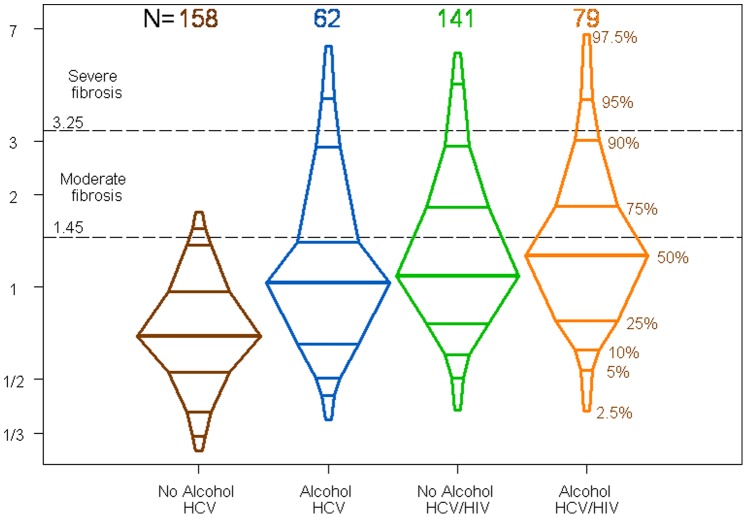
Distribution of FIB-4 scores according to unhealthy alcohol use in HCV-monoinfected and HCV/HIV-coinfected patients.